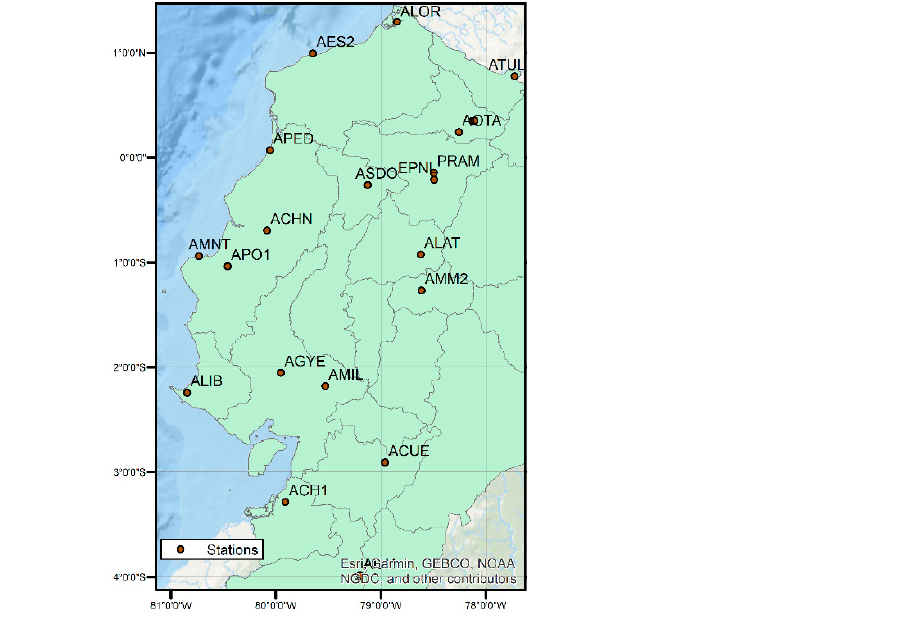
Figure 1. Strong-motion stations from the National Accelerographic Network of Ecuador (RENAC). Table 1. Values of PGA EW , PGA NS , PGA max , PGA max /PGA Larger ratio, and θ PGA(max) for the 21 ground motions recorded by the National Accelerographic Network of Ecuador. R epi : epicentral distance.